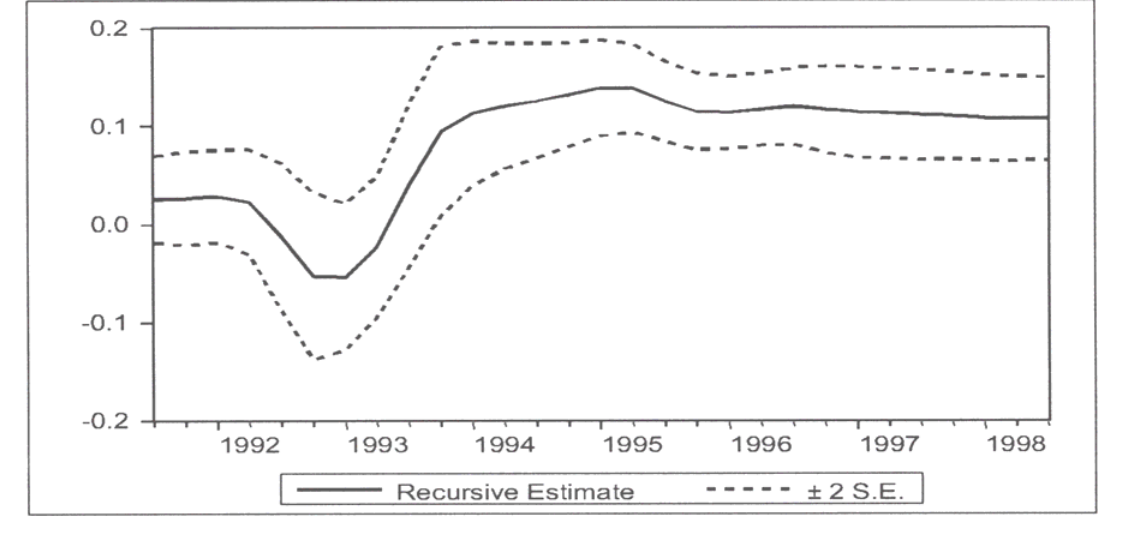
Figure 5 Coefficient stability of regression of yield curve on